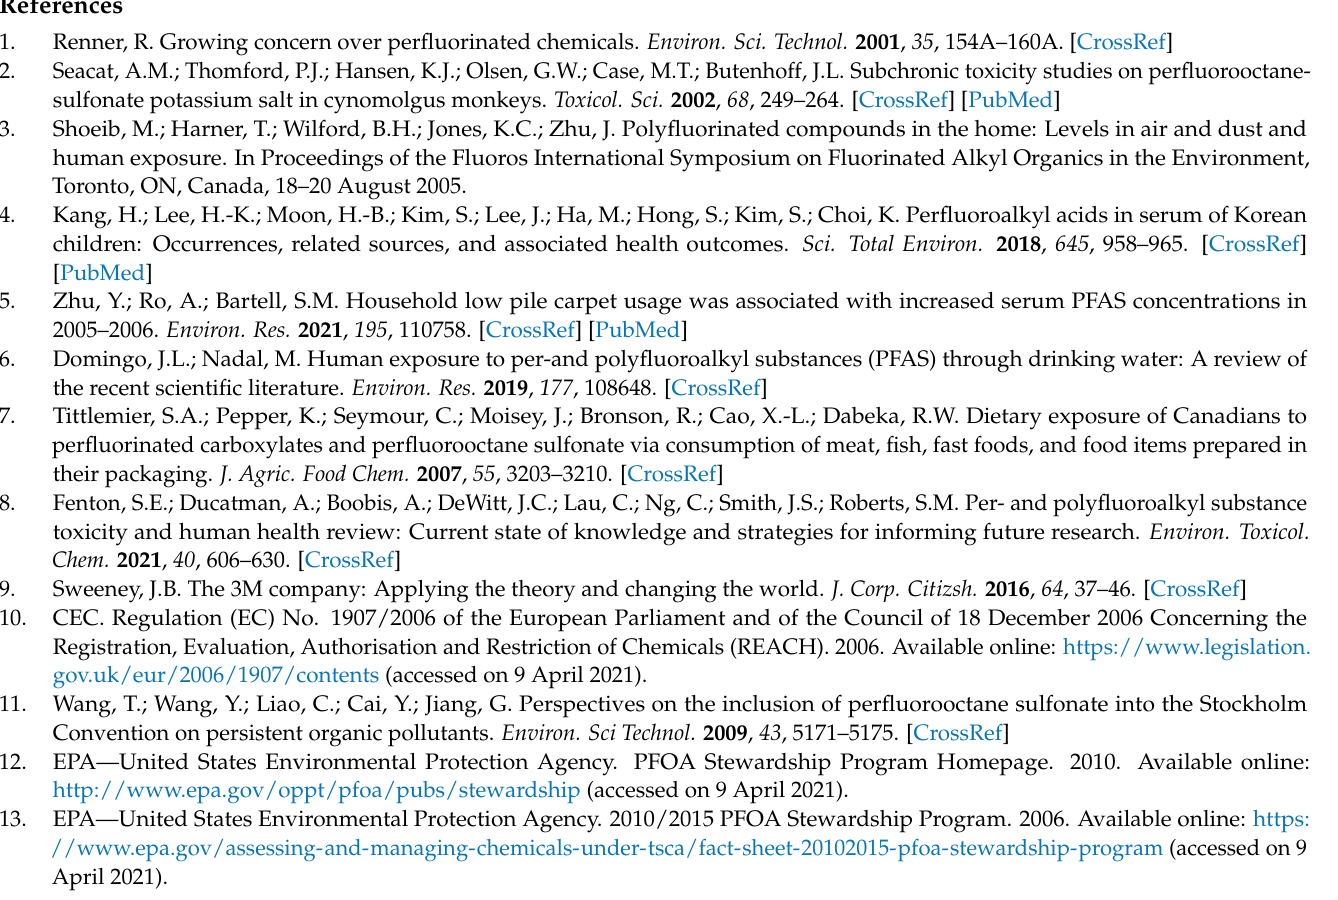
(PFASs) in serum; Table S2: LC-MS/MS conditions for determination of perfluoroalkyl